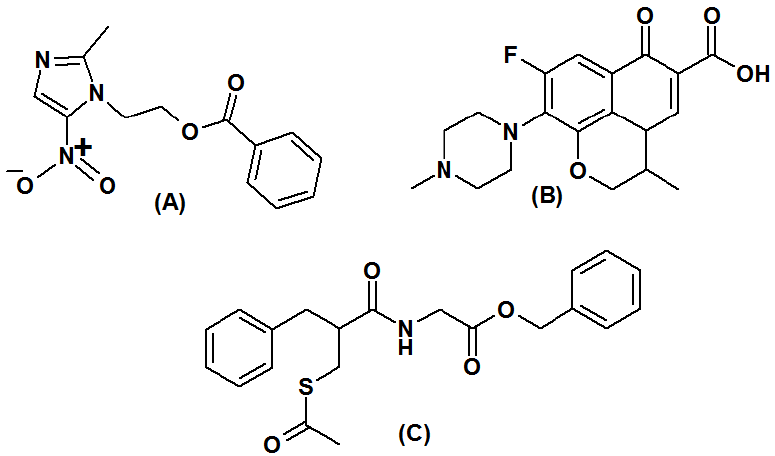
Figure 1. Chemical structure of ( A ) metronidazole benzoate, ( B ) ofloxacin, and ( C )